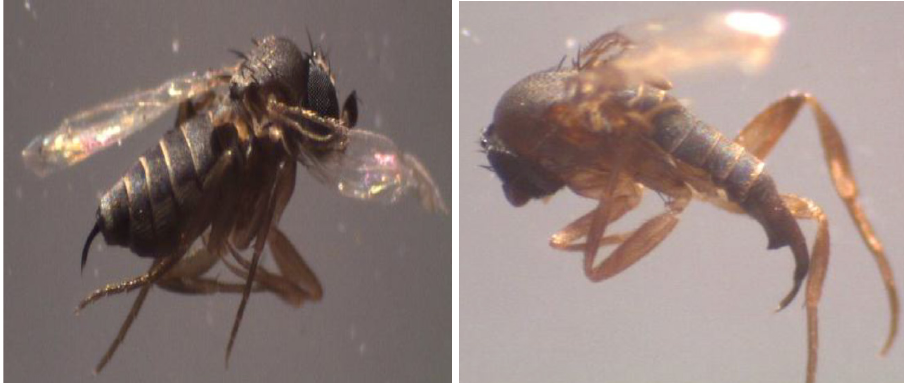
Fig 3. Species collected from the genus Myrmosicarius .